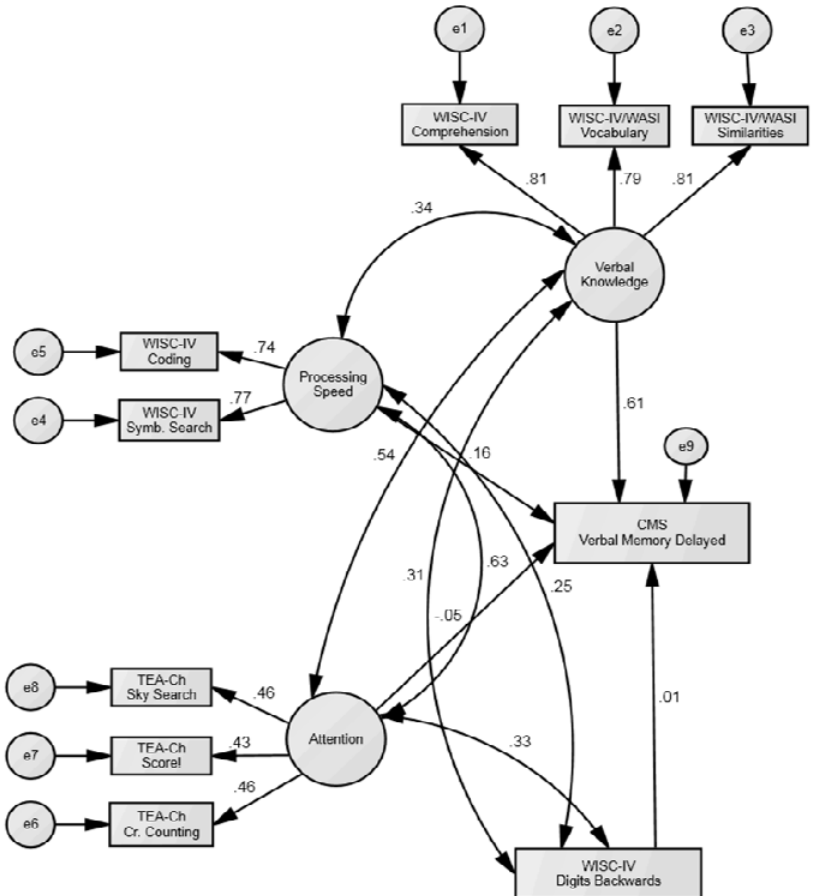
Figure 2. Final structural equation model (SEM) of factors contributing to verbal memory performance. The figure shows the final SEM with the standardized regression estimates added. Circles represent latent variables ( i.e ., the cognitive factors), and rectangles represent measured variables. Double-headed arrows indicate covariance, whereas single-headed arrows represent one-way relationships. (WASI)